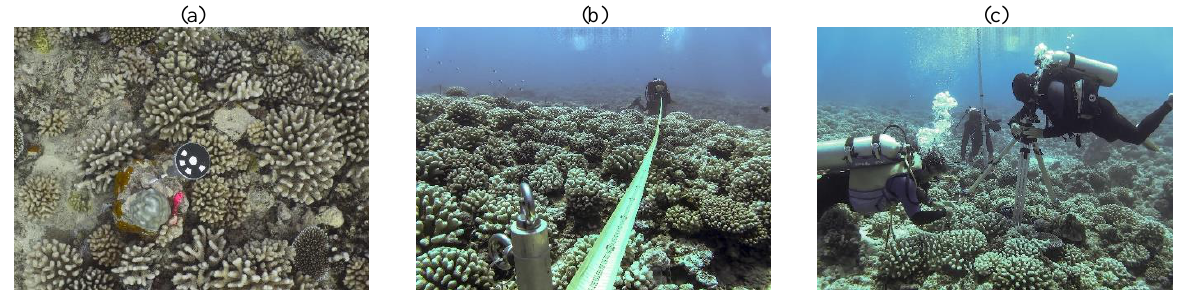
Figure 3. (a) Underwater reference point (RP). (b) RP-to-RP distance measurement (image acquired a moment before the tape was straightened for measurement reading); (c) RP-to-RP relative height difference measurement by leveling, using an underwater green laser pointer mounted on a tripod.